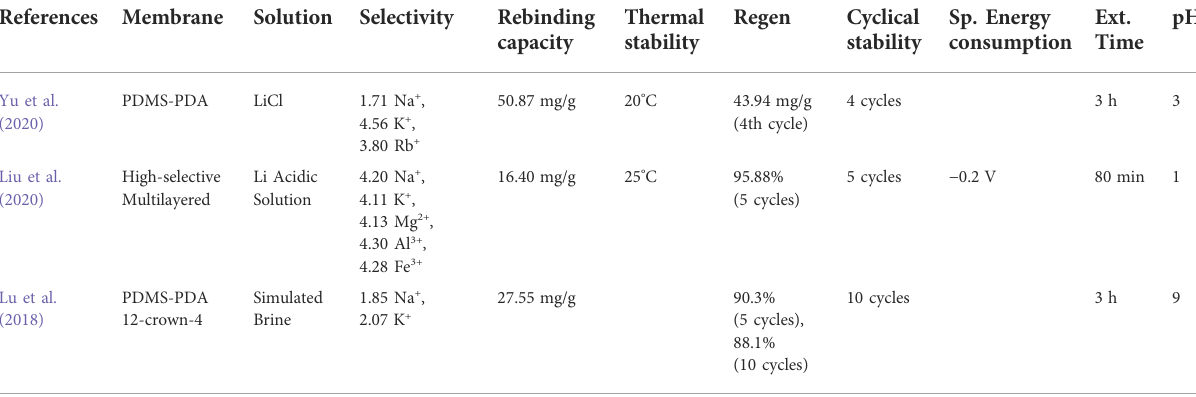
TABLE 8 Li + IIM extraction from simulated